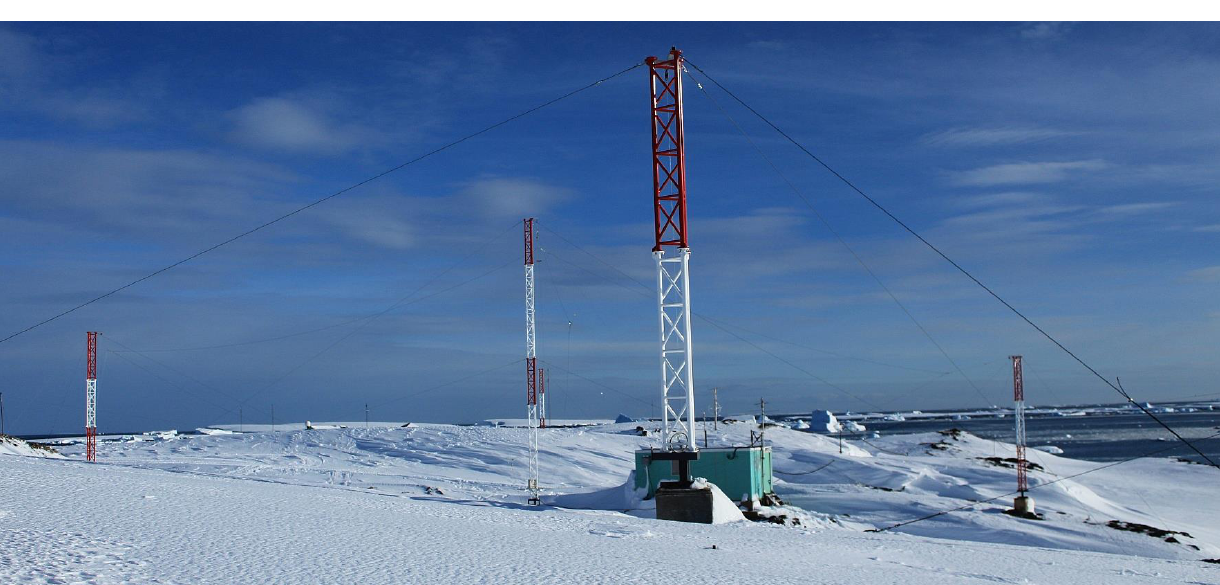
Figure 4. Antenna system of passive ionosonde at UAS.